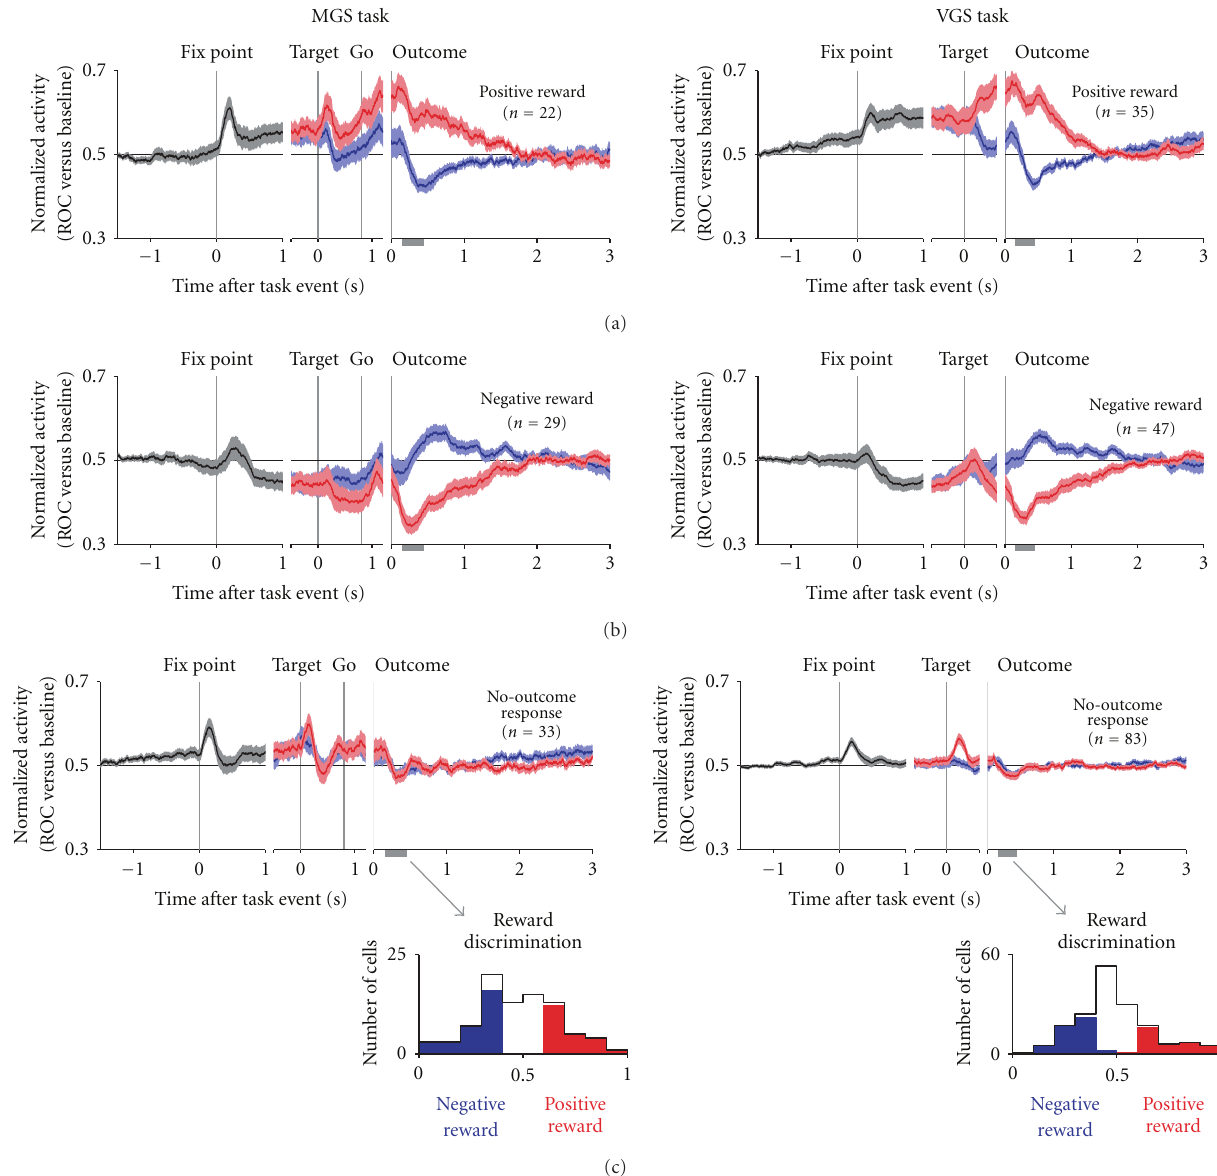
Figure 9: Population-averaged activity of DRN neurons separated by their reward signals in response to the outcome. (a–c) Normalized activity is shown for the memory-guided saccade task (MGS, left) and visually-guided saccade task (VGS, right), shown separately for positive-reward neurons (a, top), negative-reward neurons (b, middle), and no-outcome response neurons (c, bottom). The colors indicate the average of all trials (black), large-reward trials (red), and small-reward trials (blue). The neurons were sorted into these categories on the basis of significant reward discrimination after outcome onset (gray bar on the x -axis; P < 0 . 05, Wilcoxon rank-sum test). The histograms below (c) show the reward discrimination for each neuron, with the colors indicating positive-reward neurons (red) and negative-reward neurons (blue). For the plots of normalized activity, the activity of each neuron was normalized by computing its ROC area versus baseline activity during the intertrial interval. The thick lines indicate the mean normalized activity, and the light shaded areas are ± 1SEM. (Modified from